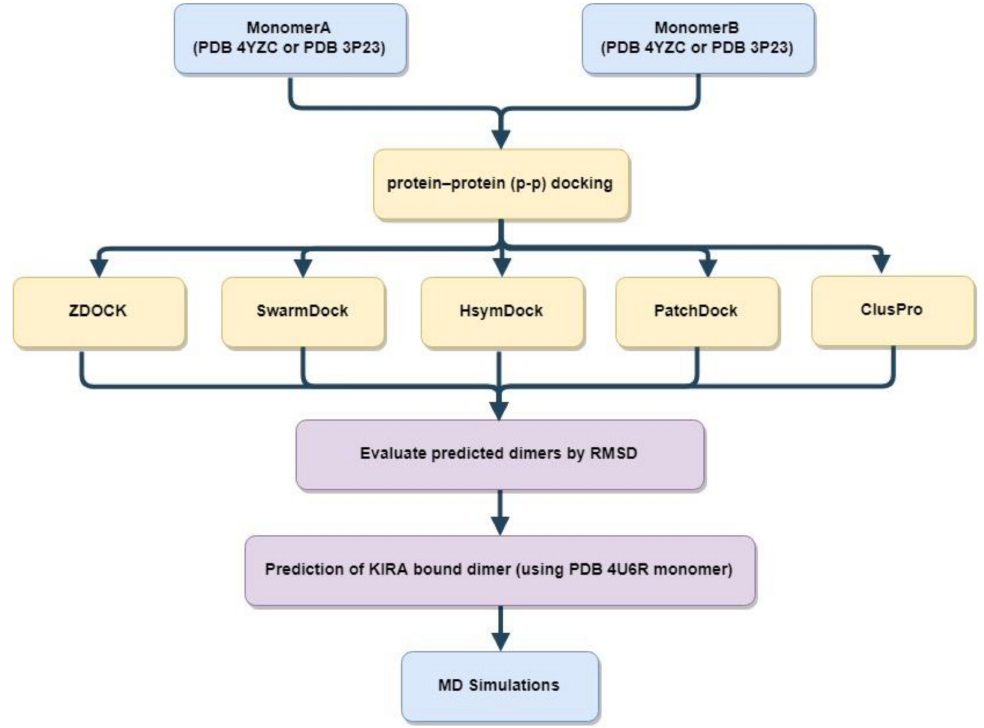
Figure 2. Schematic representation of the protein–protein docking scheme used for predicting KIRA-bound dimer structures. RMSD stands for the root mean square deviation calculated for C α atoms by superposing the docked structure with the crystallographic